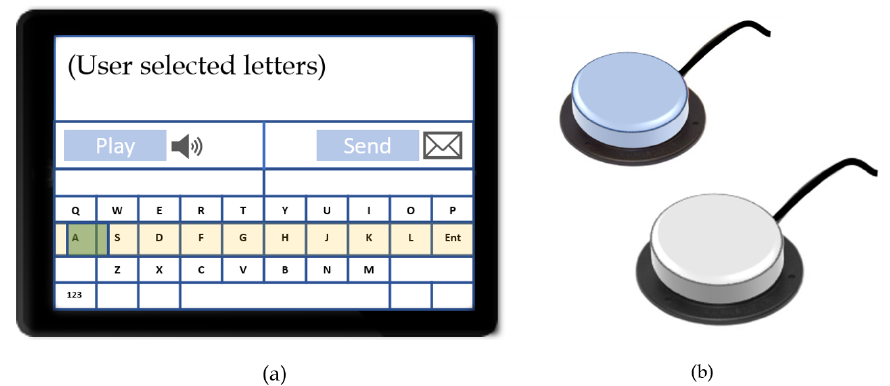
Figure 3. ( a ) A sample visual scanning interface activated via switch scanning. The yellow box moves vertically across the lines until a selection is made, followed by a gliding green box moving horizontally across the highlighted line until a letter is also selected. In ( b ), two scanning button switches are